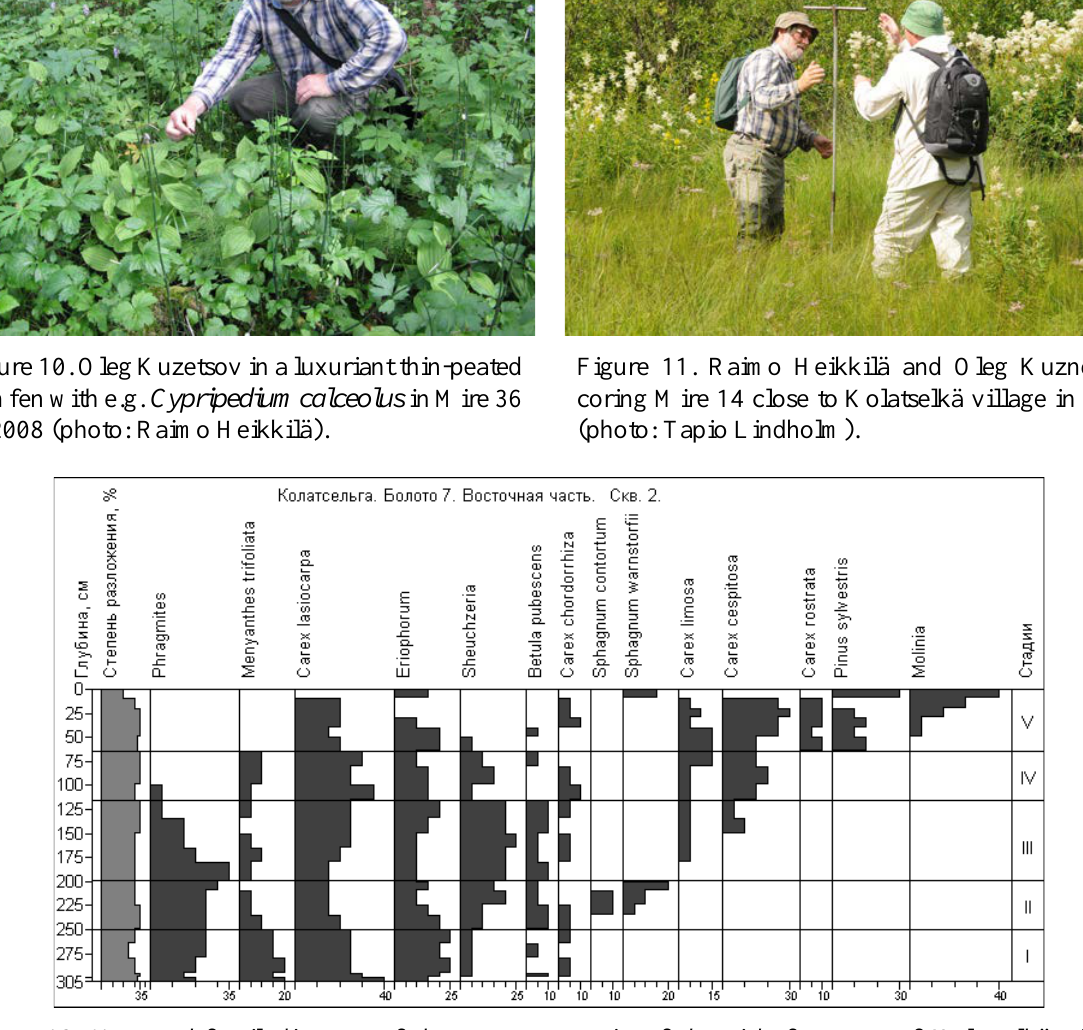
Figure 12. Macrosubfossil diagram of the eastern margin of the rich fen west of Kolatselkä village (Number 7, Lounamaa